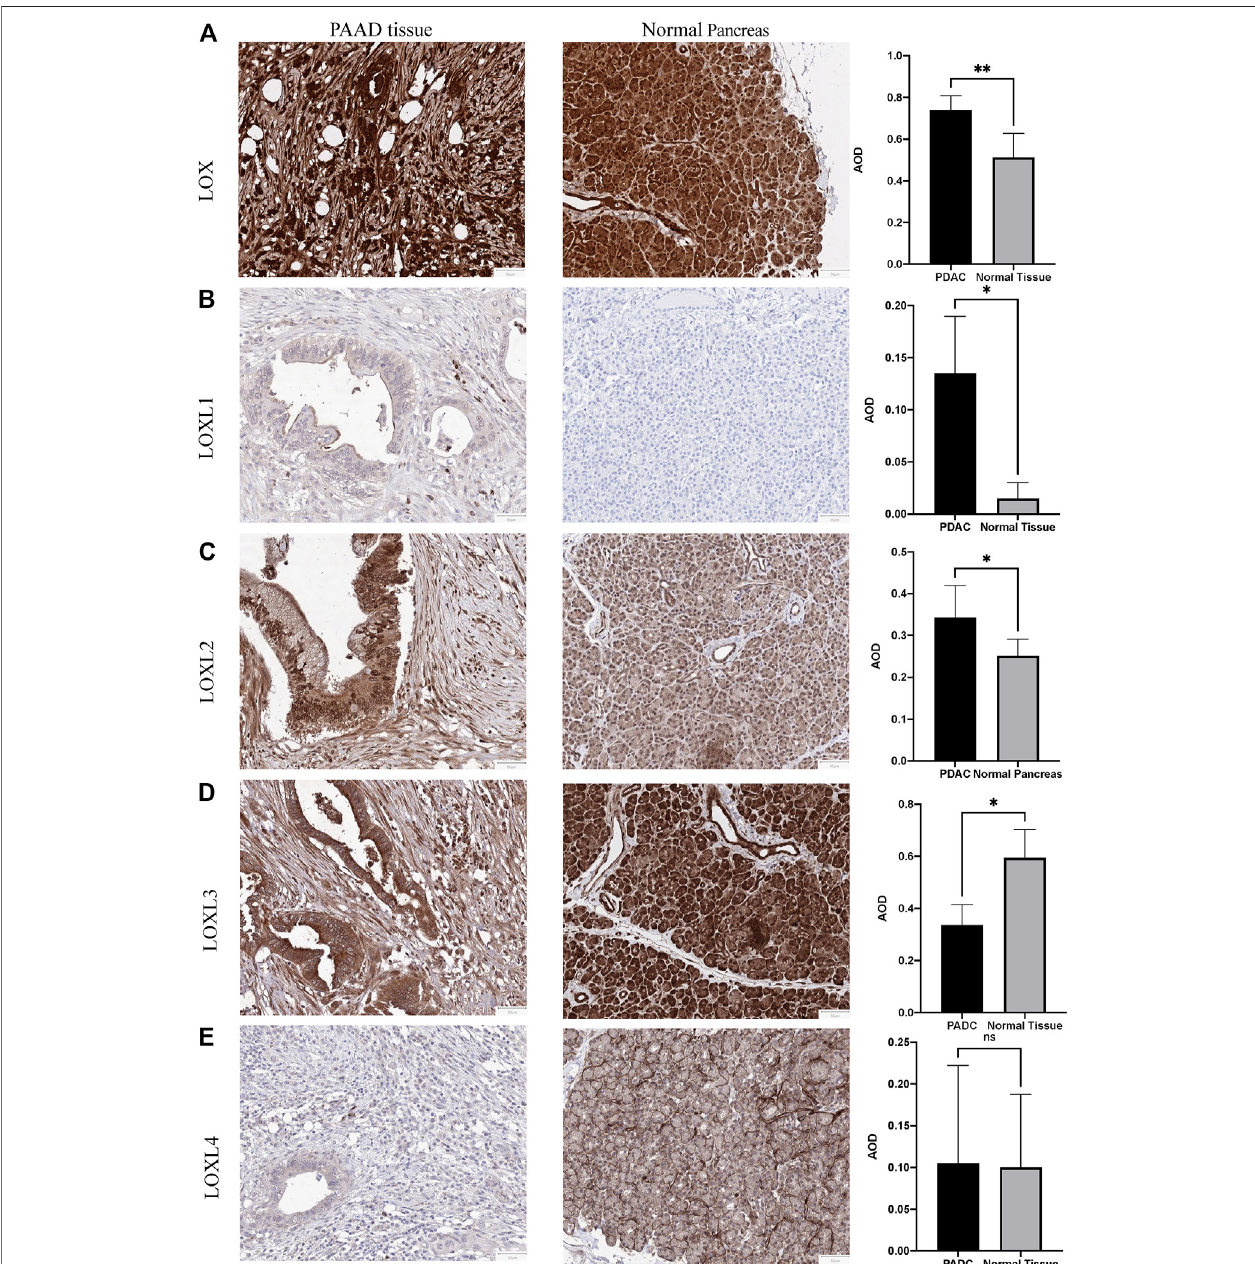
FIGURE 3 | Representative immunohistochemistry of LOXs in PDAC tissues and normal pancreas tissues. (A) IHC staining of LOX and quanti fi cation showed higher expression in PDAC than normal pancreas tissues. (B) IHC staining and quanti fi cation showed higher expression of LOXL1 in PDAC. (C) IHC staining and quanti fi cation showed higher expression of LOXL2 in PDAC. (D) IHC staining and quanti fi cation showed lower expression of LOXL3 in PDAC. (E) LOXL4 expression levels were similar in PDAC and normal tissues. * p < 0.01; NS, no signi fi cant difference. n = 6, repeated 5 times.